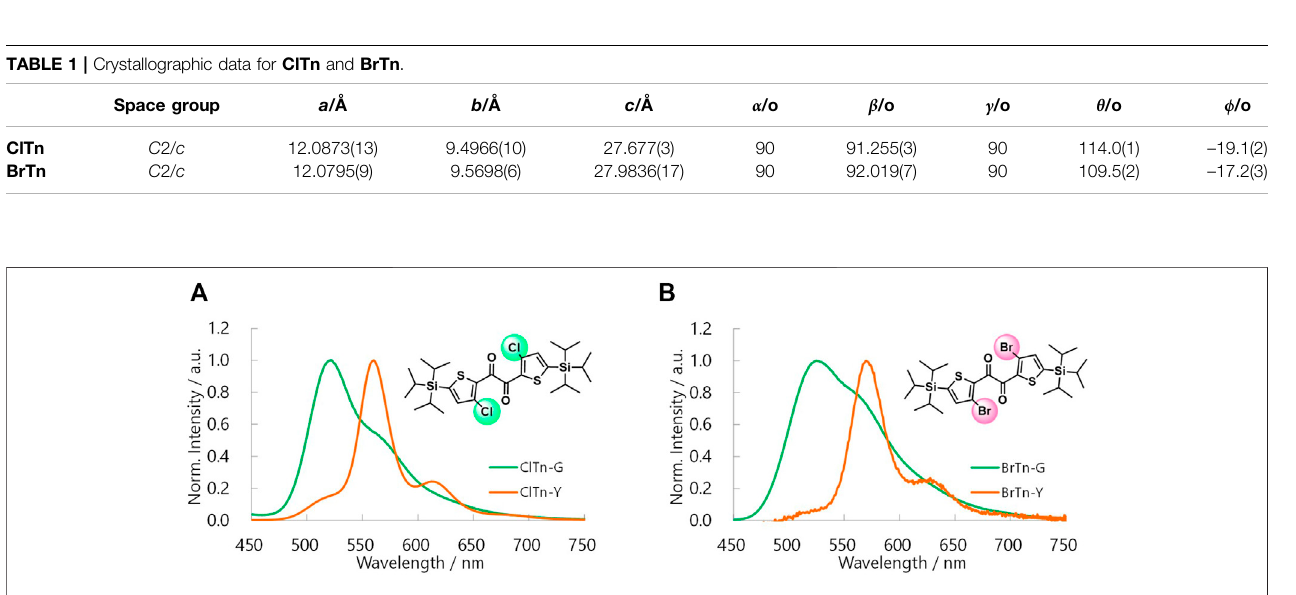
difference spectrum corresponds to the pure PL spectrum of the TP conformer. The difference spectrum and the spectrum of ClTn-G were multiplied by α Y (cid:2) [ Φ p of BrTn-Y ]/[ Φ p of